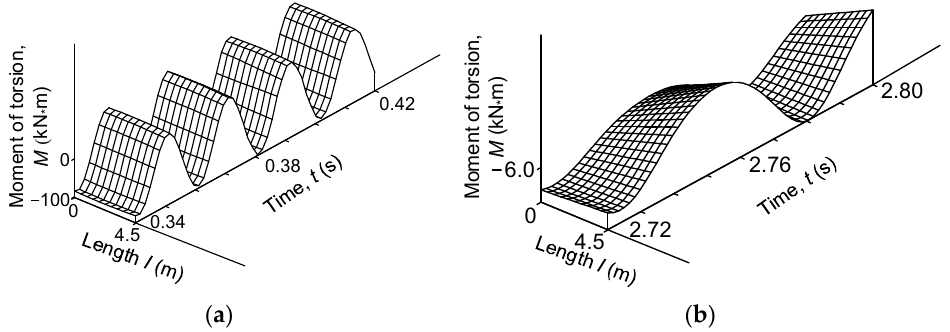
Figure 13. Spatial–temporal waveforms of ( a ) shaft angular velocity and ( b ) angle of shaft rotation.